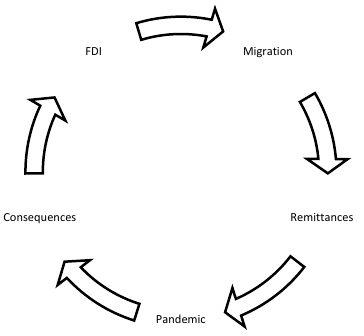
Figure 1. FDI, migration and COVID-19. Source: Authors.